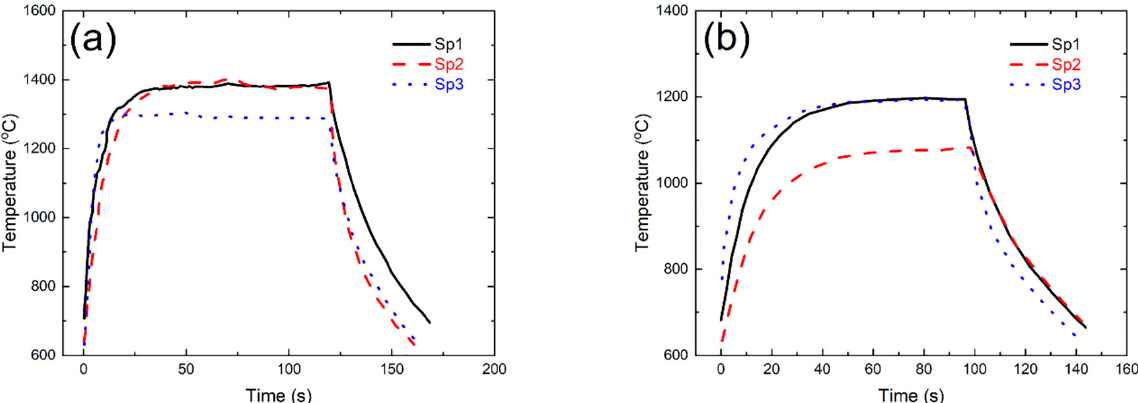
Figure 6. The temperature change with time for different measurement spots during thermal shock test ( a ) Left guide vane; and ( b ) Right guide vane.